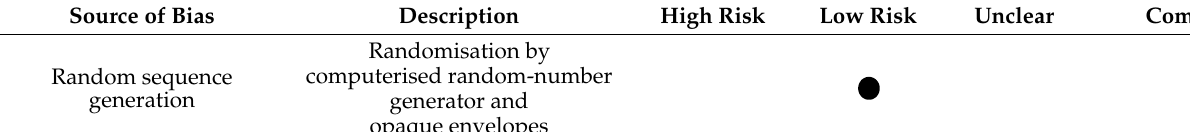
Table 2. Risk-of-bias assessment for Kallio et al., 2015 [27].